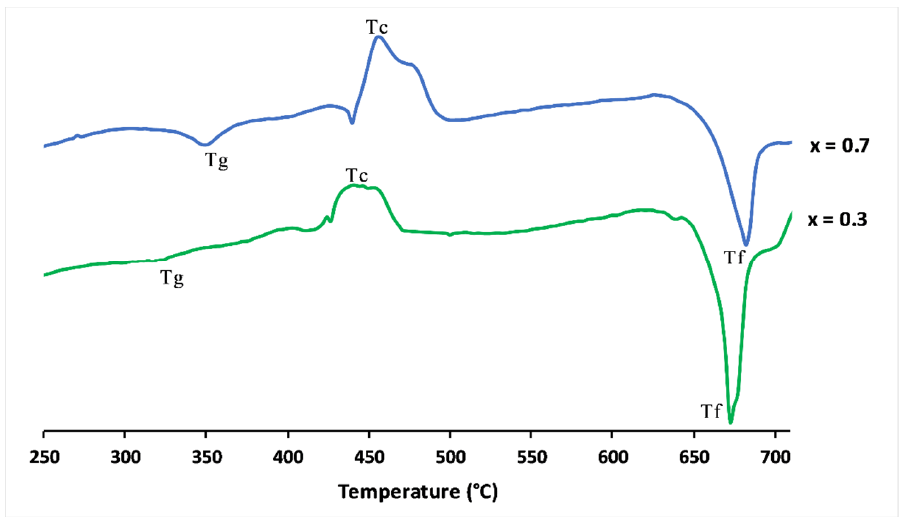
Figure 3. Differential scanning calorimetry curves of 3P 2 O 5 -2K 2 O-0.7CaO-0.3MgO and 3P 2 O 5 -2K 2 O- 0.3CaO-0.7MgO glasses.